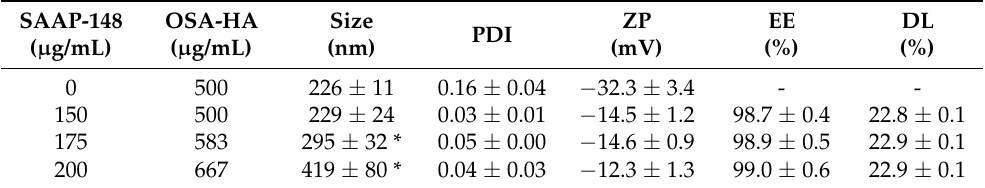
Table 1. Physicochemical properties of freshly produced OSA-HA nanogels prepared with increasing amounts of SAAP-148.